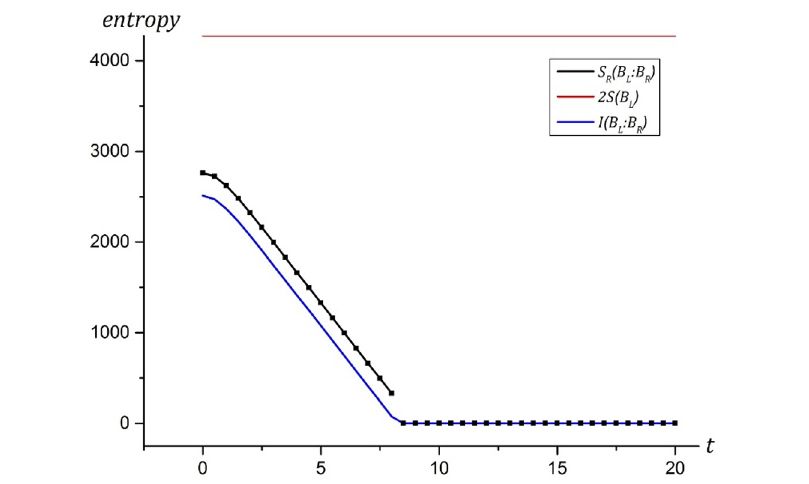
Figure 20 . S R ( B L : B R ) with the upper bound 2 S ( B L ) and the lower bound I ( R L : B L ) , with respect to t . We pick b = 1 , φ r = 100 , S 0 = c = 1000 and (cid:15) UV = 0 . 01 . Notice that the